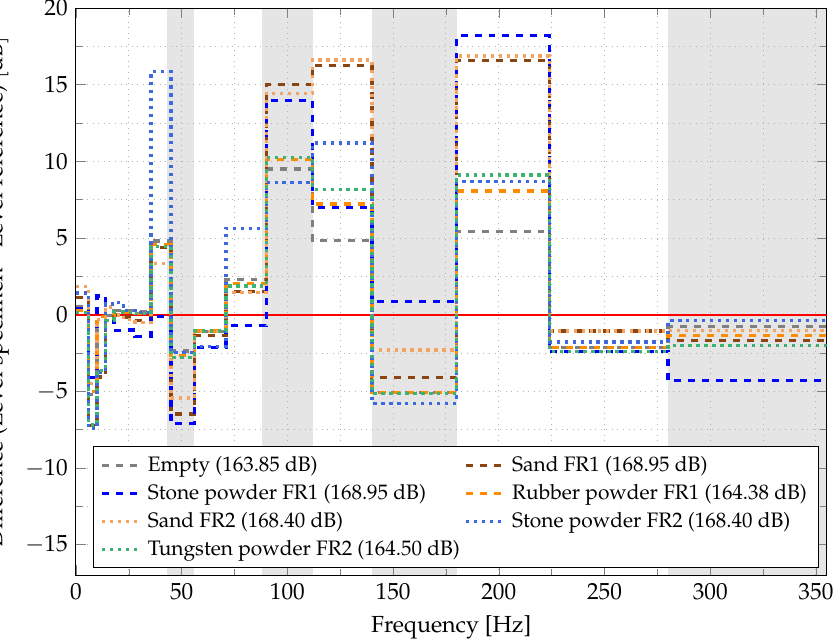
Figure A5. Difference in one-third octave band: FRF of SU HCDP mounted to the outer wall of the stator ring (opposite to the excitation point). SL of surface velocity is given in dB..